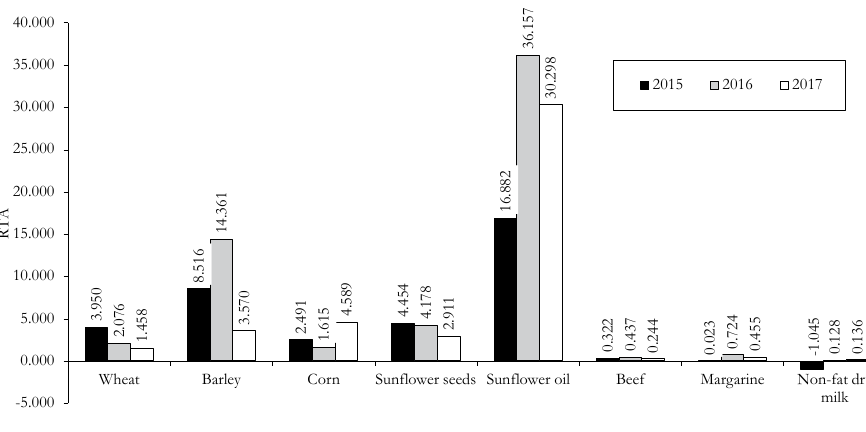
Fig. 2 – Pattern of international competitiveness of the goods prevailing in agri-food export of Ukraine, 2015–2017 (based on the calculations of relative trade advantages indices RTAij). Source: compiled by the author on the basis of (FAOSTAT,